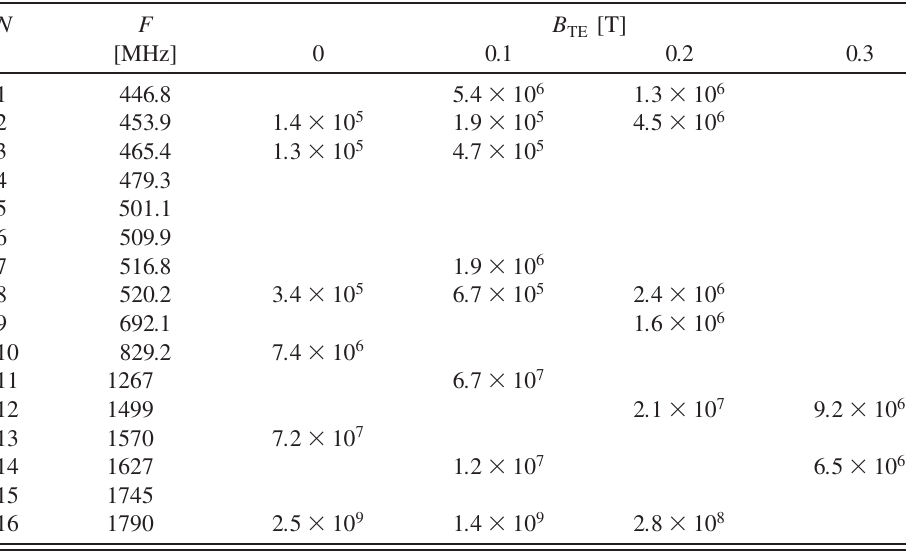
TABLE IV. Breakup instability threshold currents multiplied by Q factor ( I thr Q [A]) for all considered dipole modes of the LEP cavity for different values of the maximum TE 021 mode magnetic field ( B TE ) on the cavity axis. Blank spaces are corresponded to infinite values.